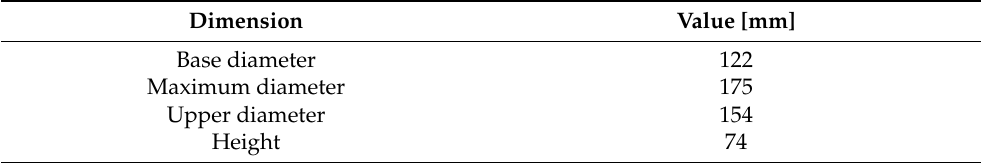
Table 1. Main dimensions of the impeller of the SP 215 pump measured by adopting the traditional measuring instruments (i.e., caliper and micrometer). For the visualization of the dimensions refer to Figure 3.